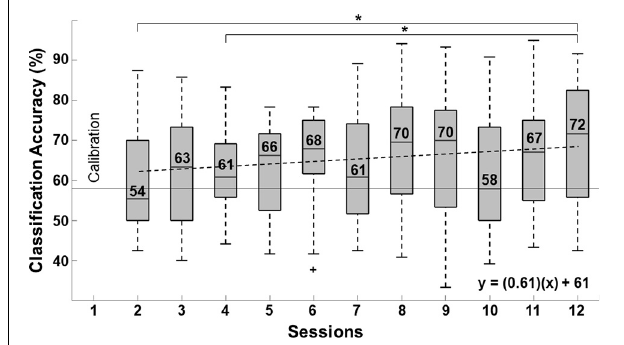
FIGURE 7 | Linear trend of BCI performance measured with the percentage of classification accuracy (%CA). Significant differences ( p < 0.005) in %CA between consecutive sessions are indicated with (*). Outliers are also marked (+). The practical level of chance is shown as a horizontal broken line.